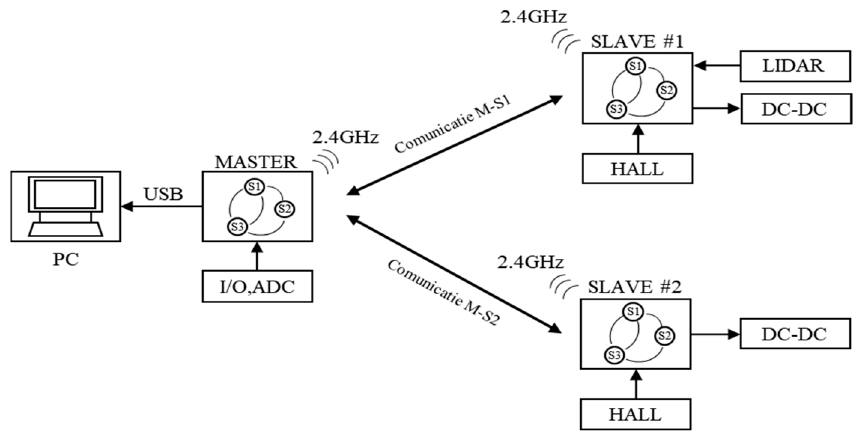
Figure 6. Basic schematic of the LiDAR testing platform.